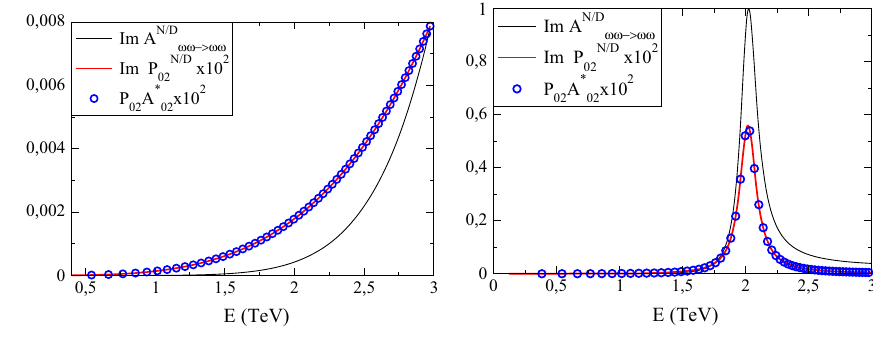
Fig. 9 P 02 isoscalar, tensor amplitude in the N/D method. Left Same parameters as in Fig. 4. Right We increase a 4 = 3 × 10 − 3 to induce a tensor resonance in the elastic ωω amplitude that is neatly reproduced in the photon–photon amplitude.